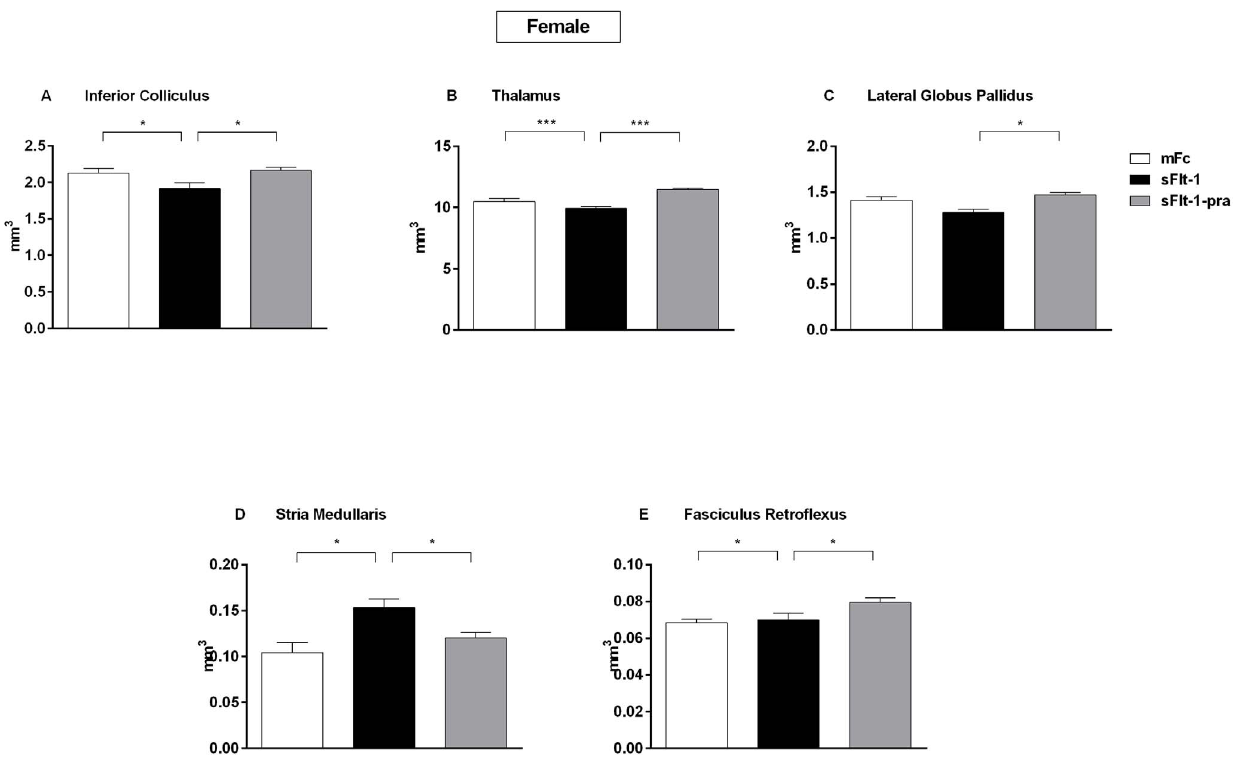
Figure 2. Altered Brain Volumes in 6 Month Old Female Offspring Brain. Regions of interest were analyzed by 1-way ANOVA in 6 month old female mice offspring born to pregnant CD1 mice injected either with an adenovirus carrying sFlt-1 or adenovirus carrying mFc fragment. Mice injected with sFlt-1 were treated with either pravastatin or water to result in three groups of offspring animals: mFc (n=6), sFlt-1 (n=3), and sFlt-1-pra (n=10). Data are reported as mean 6 SEM. The sFlt-1 group offspring showed decreased volumes at the inferior colliculus (A; p=0.04), thalamus (B; p , 0.0001), and lateral globus pallidus (C; p=0.02) when compared to the mFc control offspring. Increased volumes were seen at the stria medullaris (D; p=0.01), and fasciculus retroflexus (E; p=0.01). The overall ameliorative effect of pravastatin exposure in utero is seen. Not shown are brain regions with similar volumes between groups.